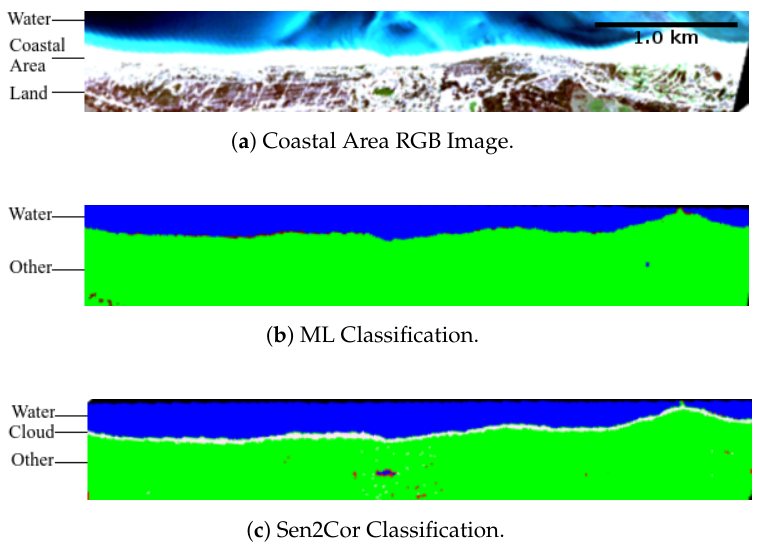
Figure 8. A Coastal Area Image (Lisbon, Portugal, between (38 ◦ 29’28" N , 8 ◦ 55’ W) and (38 ◦ 26’11" N, 8 ◦ 49’18" W)) with brighter surface reflectance. Color Labels: Water (Blue), Cloud (White), Other (Green) .